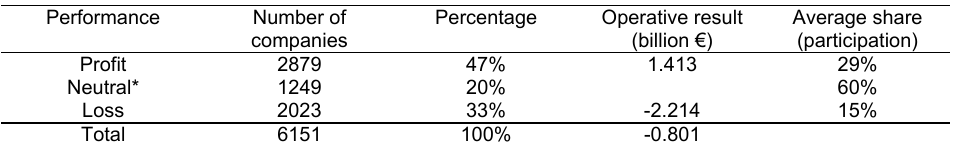
Table 2: participated companies (by local administrations)